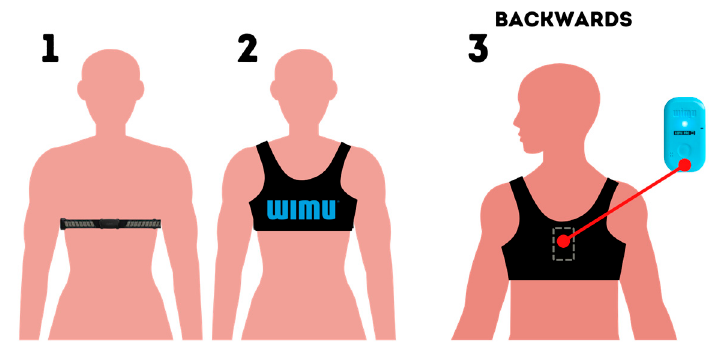
Figure 3. Heart rate band and inertial device placement.